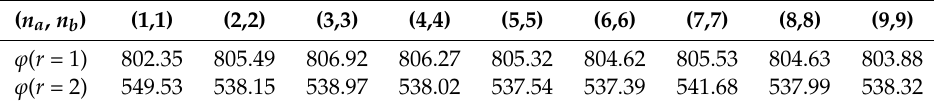
Table 1. The index φ for different model parameters.